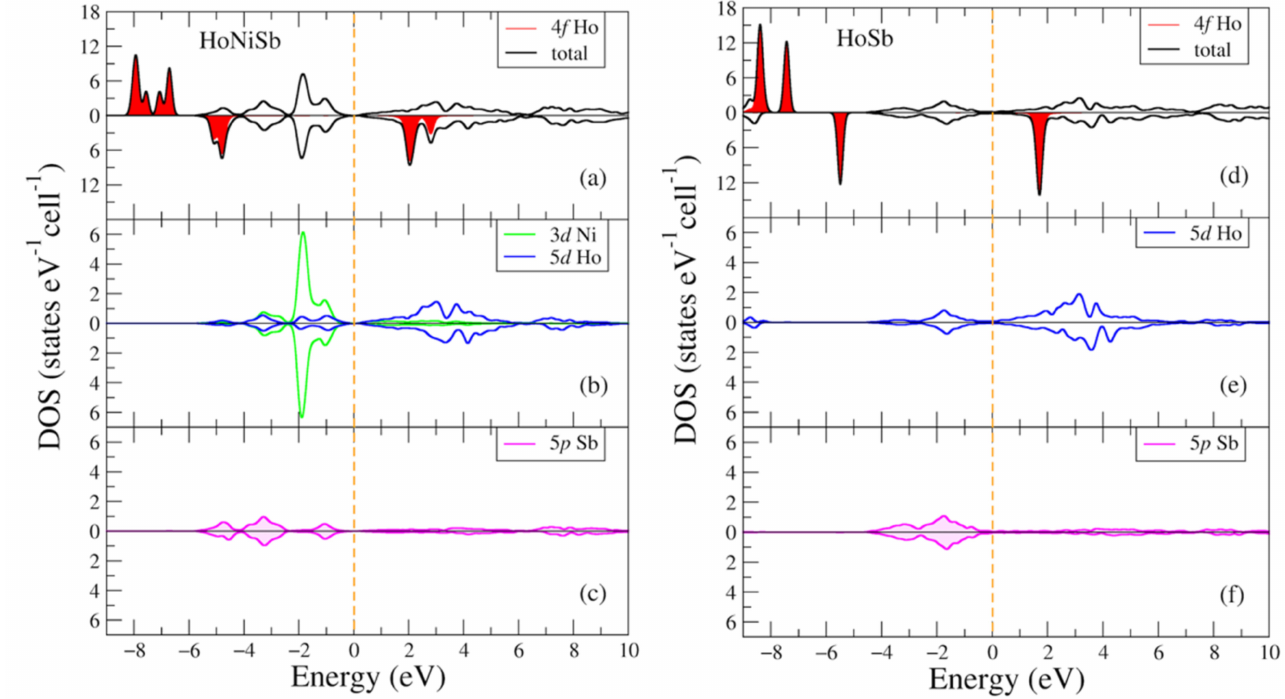
Figure 8. Densities of electronic states from DFT+U for ( a – c ) HoNiSb; ( d – f ) HoSb per cell. ( a , d ) Total and partial Ho-4f densities of states; ( b , e ) partial density of states for Ho-5d (Ni-3d); ( c , f ) partial density of states for Sb-5p. The plot is shifted relatively to the Fermi energy shown at zero as a vertical dashed